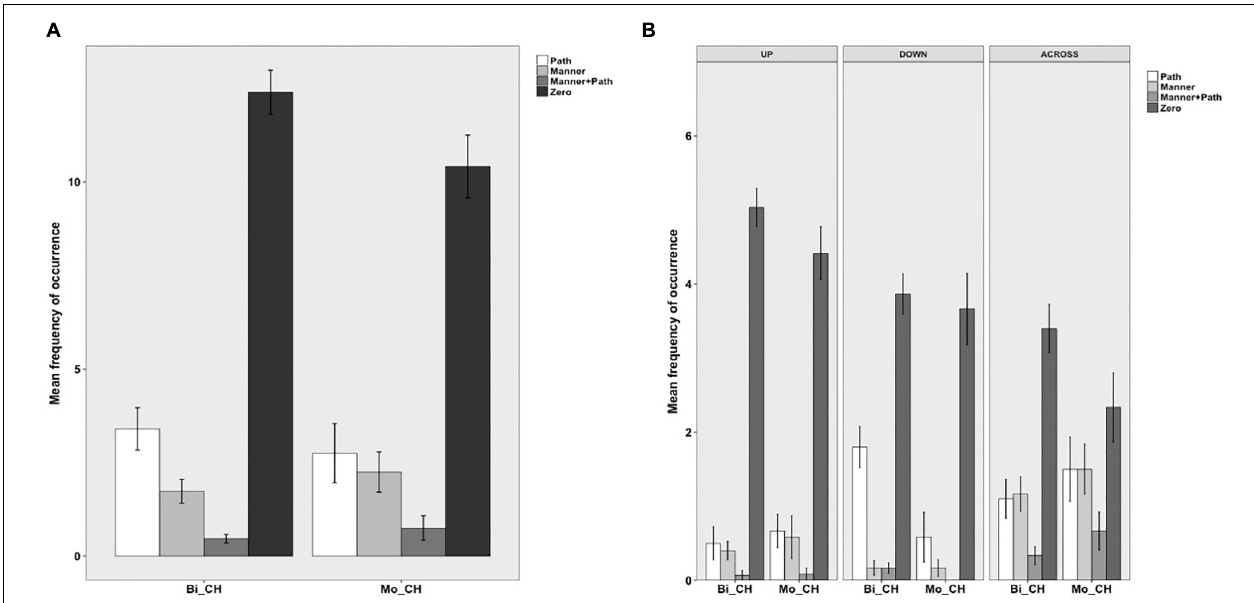
FIGURE 4 | Information in the OTHER locus in